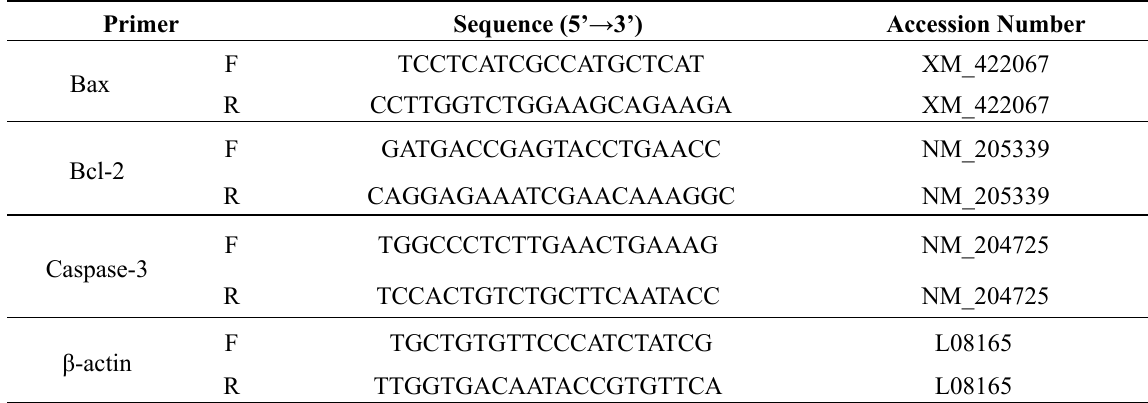
Table 1. Nucleotides used as primers in qRT-PCR analysis of mRNA expression in the